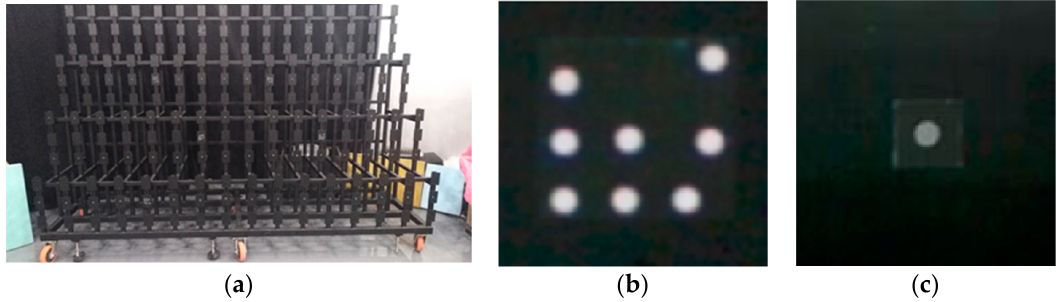
Figure 8. 3D control field and reflective target: 3D control field ( a ); large reflective target ( b ); small reflective target ( c ) . Sensors 2019 , 19 , 5082